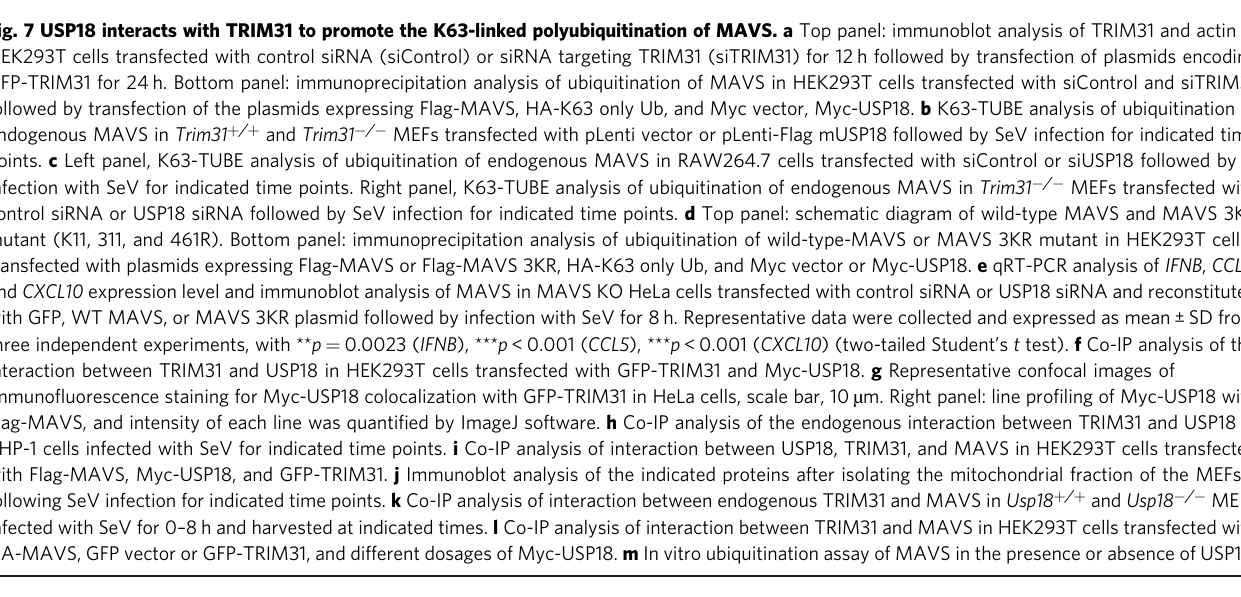
Fig. 7 USP18 interacts with TRIM31 to promote the K63-linked polyubiquitination of MAVS. a Top panel: immunoblot analysis of TRIM31 and actin in HEK293T cells transfected with control siRNA (siControl) or siRNA targeting TRIM31 (siTRIM31) for 12 h followed by transfection of plasmids encoding GFP-TRIM31 for 24 h. Bottom panel: immunoprecipitation analysis of ubiquitination of MAVS in HEK293T cells transfected with siControl and siTRIM31 followed by transfection of the plasmids expressing Flag-MAVS, HA-K63 only Ub, and Myc vector, Myc-USP18. b K63-TUBE analysis of ubiquitination of endogenous MAVS in Trim31 + / + and Trim31 − / − MEFs transfected with pLenti vector or pLenti-Flag mUSP18 followed by SeV infection for indicated time points. c Left panel, K63-TUBE analysis of ubiquitination of endogenous MAVS in RAW264.7 cells transfected with siControl or siUSP18 followed by infection with SeV for indicated time points. Right panel, K63-TUBE analysis of ubiquitination of endogenous MAVS in Trim31 − / − MEFs transfected with control siRNA or USP18 siRNA followed by SeV infection for indicated time points. d Top panel: schematic diagram of wild-type MAVS and MAVS 3KR mutant (K11, 311, and 461R). Bottom panel: immunoprecipitation analysis of ubiquitination of wild-type-MAVS or MAVS 3KR mutant in HEK293T cells transfected with plasmids expressing Flag-MAVS or Flag-MAVS 3KR, HA-K63 only Ub, and Myc vector or Myc-USP18. e qRT-PCR analysis of IFNB , CCL5 , and CXCL10 expression level and immunoblot analysis of MAVS in MAVS KO HeLa cells transfected with control siRNA or USP18 siRNA and reconstituted with GFP, WT MAVS, or MAVS 3KR plasmid followed by infection with SeV for 8 h. Representative data were collected and expressed as mean ± SD from three independent experiments, with ** p = 0.0023 ( IFNB ), *** p < 0.001 ( CCL5 ), *** p < 0.001 ( CXCL10 ) (two-tailed Student ’ s t test). f Co-IP analysis of the interaction between TRIM31 and USP18 in HEK293T cells transfected with GFP-TRIM31 and Myc-USP18. g Representative confocal images of immuno fl uorescence staining for Myc-USP18 colocalization with GFP-TRIM31 in HeLa cells, scale bar, 10 µ m. Right panel: line pro fi ling of Myc-USP18 with Flag-MAVS, and intensity of each line was quanti fi ed by ImageJ software. h Co-IP analysis of the endogenous interaction between TRIM31 and USP18 in THP-1 cells infected with SeV for indicated time points. i Co-IP analysis of interaction between USP18, TRIM31, and MAVS in HEK293T cells transfected with Flag-MAVS, Myc-USP18, and GFP-TRIM31. j Immunoblot analysis of the indicated proteins after isolating the mitochondrial fraction of the MEFs following SeV infection for indicated time points. k Co-IP analysis of interaction between endogenous TRIM31 and MAVS in Usp18 + / + and Usp18 − / − MEFs infected with SeV for 0 – 8 h and harvested at indicated times. l Co-IP analysis of interaction between TRIM31 and MAVS in HEK293T cells transfected with HA-MAVS, GFP vector or GFP-TRIM31, and different dosages of Myc-USP18. m In vitro ubiquitination assay of MAVS in the presence or absence